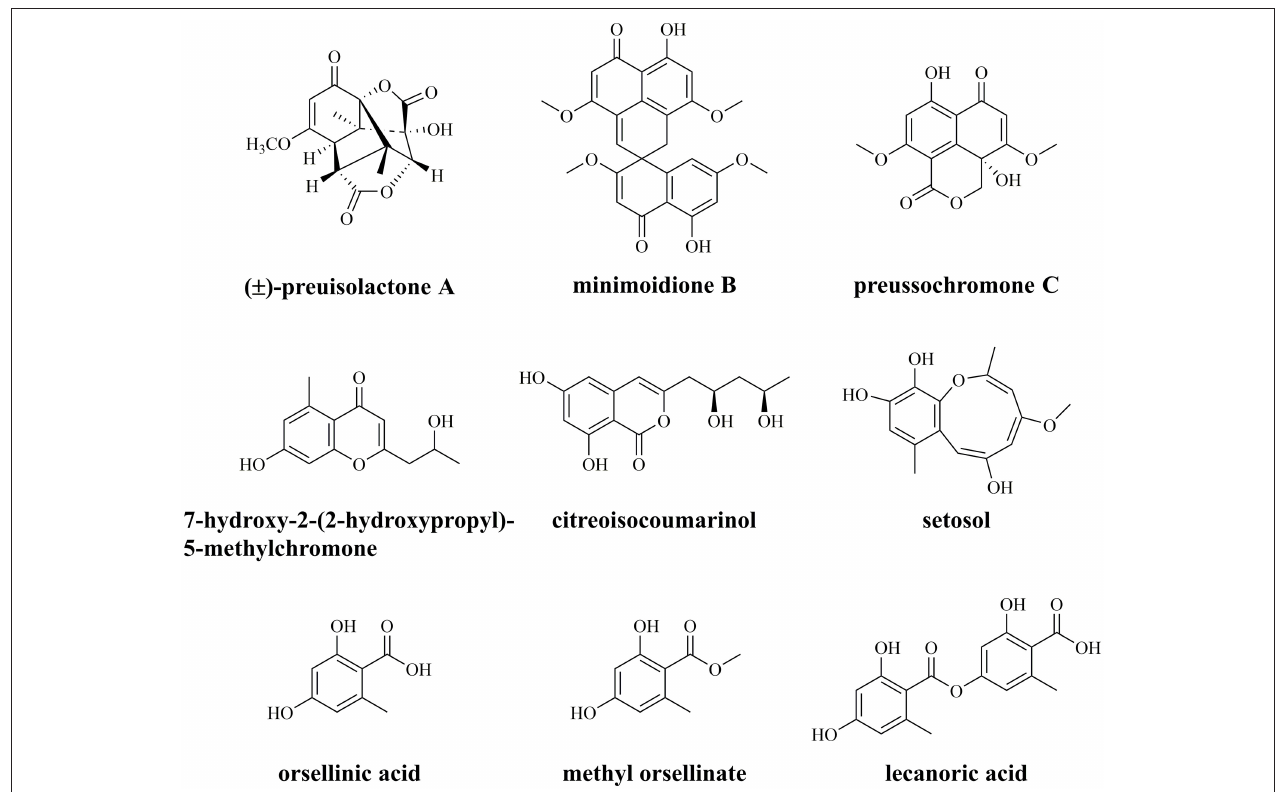
FIGURE 1 | Characterized polyketides from endophytic fungus Preussia isomera